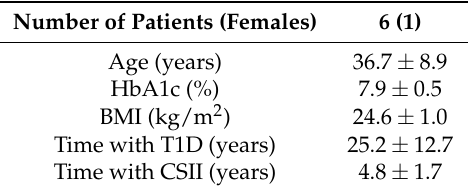
Table 1. Participants’ characteristics. Data expressed as the mean ± standard